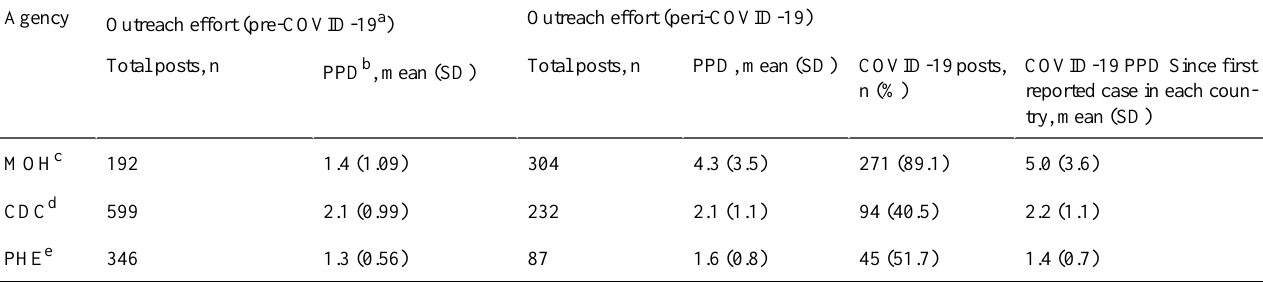
Outreach effort (peri-COVID-19)Outreach effort (pre-COVID-19 a )Agency